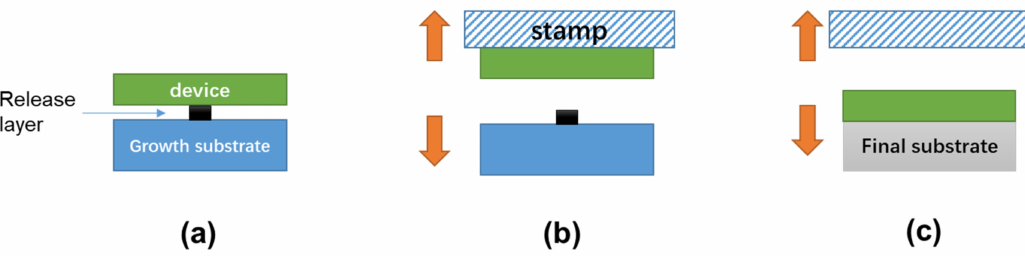
Figure 19. Working principle of the stamp transfer printing, including 3 major steps: ( a ) forming printable inks, ( b ) picking up the ink by a stamp, and ( c ) releasing the ink onto the receiving substrate by retrieving the stamp